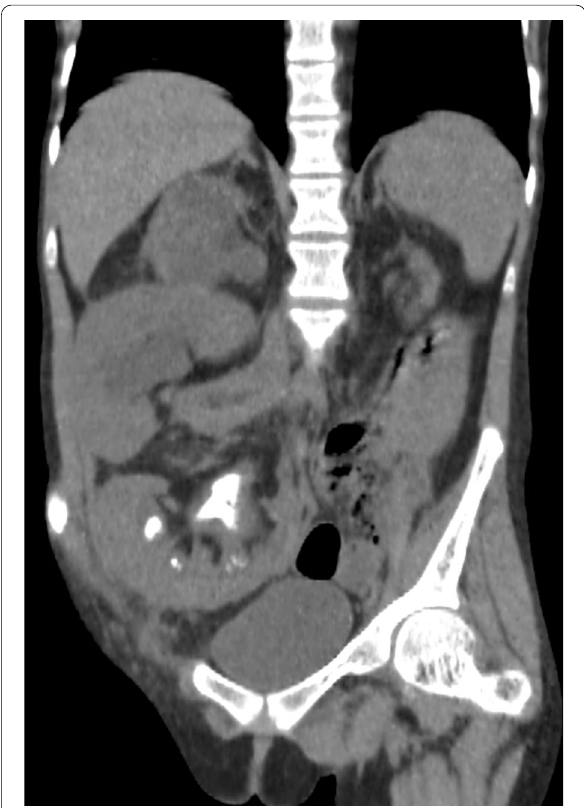
Fig. 2 Preoperative CT scan shows incomplete staghorn calculi in right iliac fossa transplanted kidney and right native and flank transplanted kidneys dilated by ureteral stone